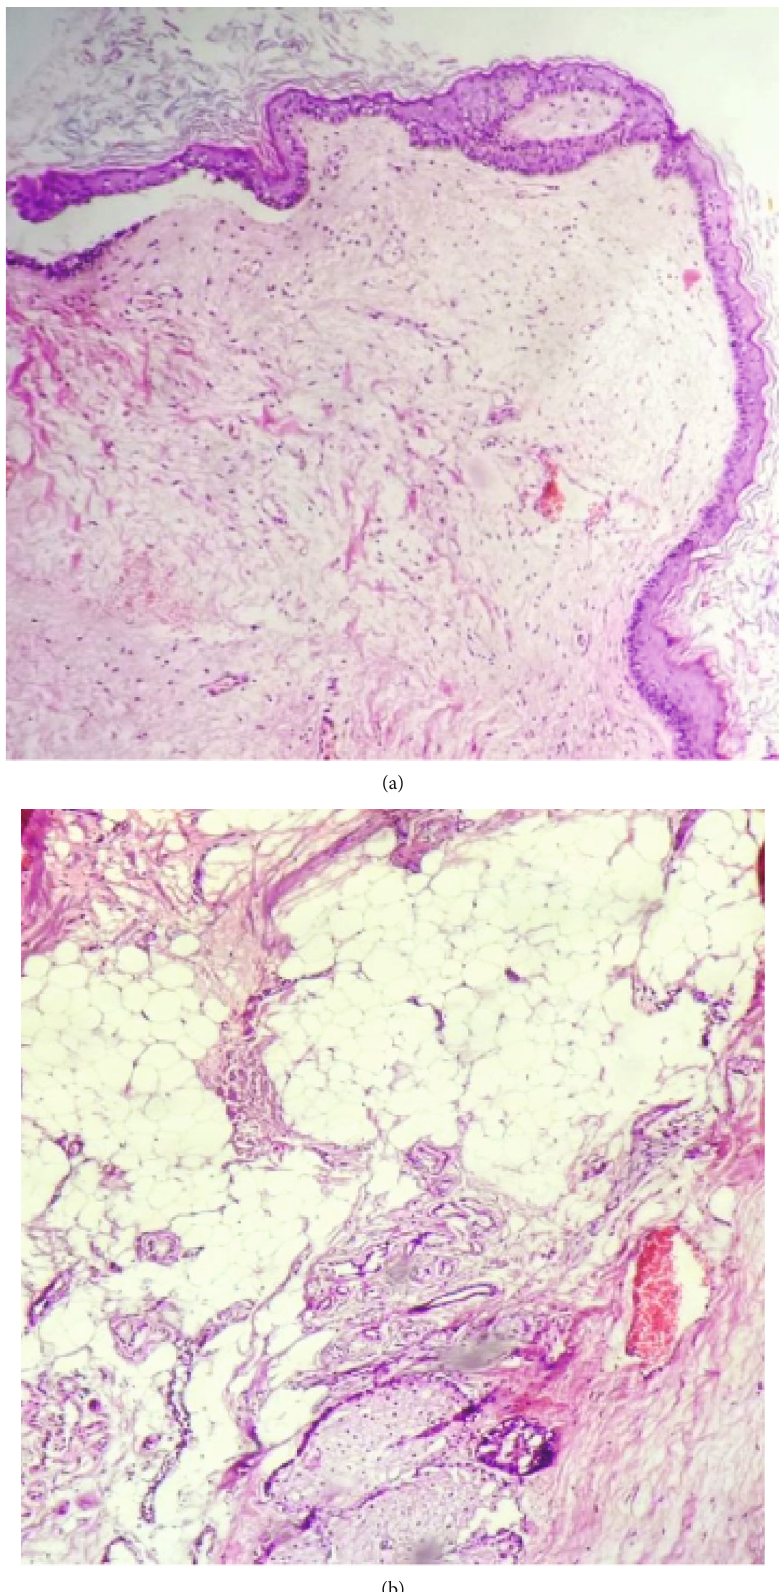
Figure 4: (a) Sections show keratinized strati fi ed squamous epithelium with adnexal structures. (b) Mature fatty tissue with adnexal structures (5x magni fi